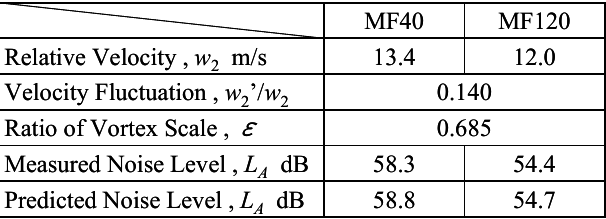
Table 3 Summary of the wake characteristics and noise